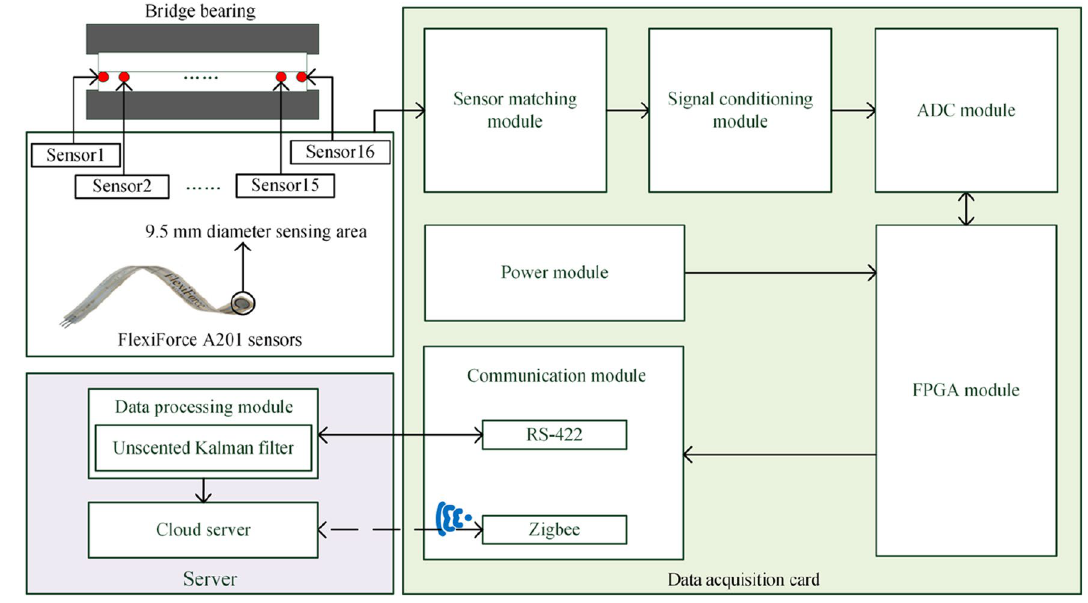
Figure 1. Block diagram of bridge support monitoring